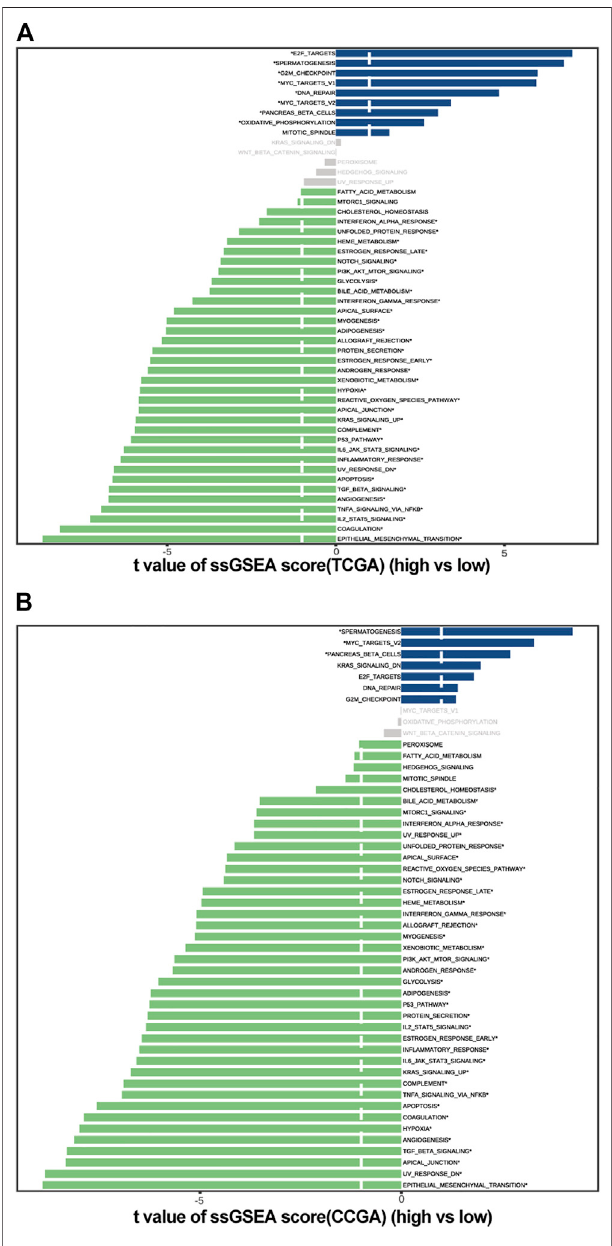
FIGURE 7 | Pathway enrichment analysis in high and low c_mRNAsi groups. (A) . Pathway enrichment analysis in TCGA. (B) . Pathway enrichment analysis in